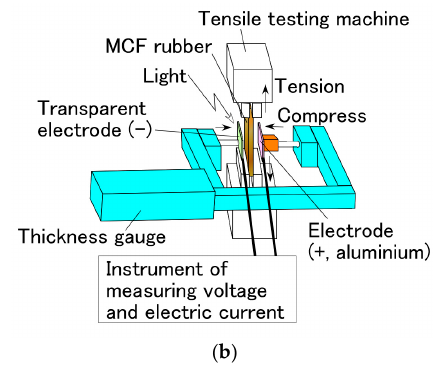
Figure 9. Schematic diagram of experimental apparatus for measuring photoelectricity and piezoelectricity of wet-type MCF rubber solar cell under tension and compression: ( b ) is viewed at an angle on ( a ).